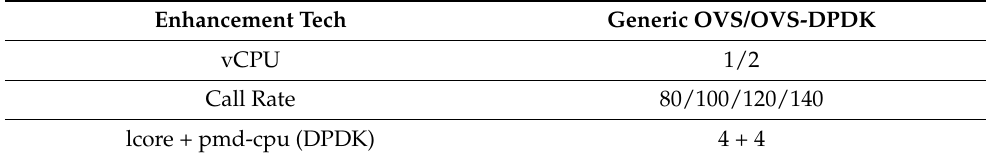
Table 4. Experimental settings in application tests.